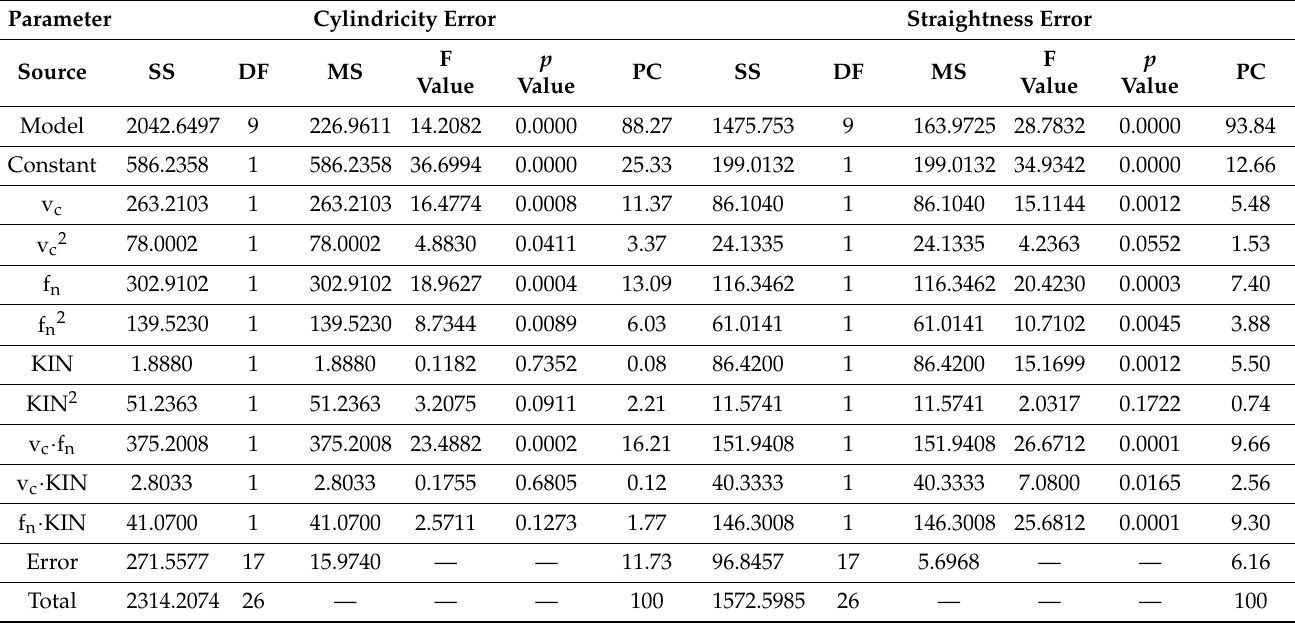
Table 5. ANOVA results including the percentage contribution (PC) of the process parameters and the type of kinematic system for the cylindricity and straightness errors.